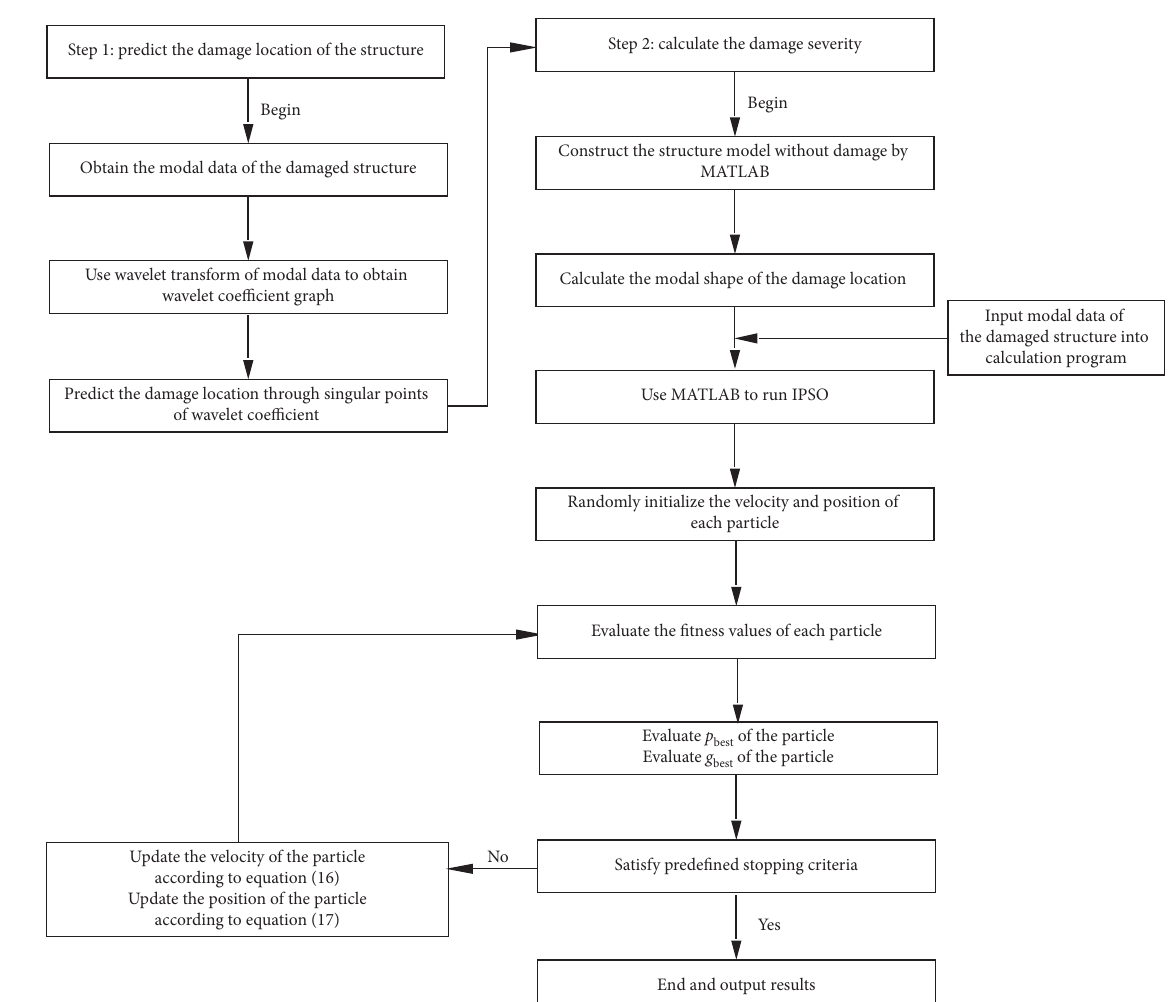
Figure 1: Damage identification flowchart of WIPSO.